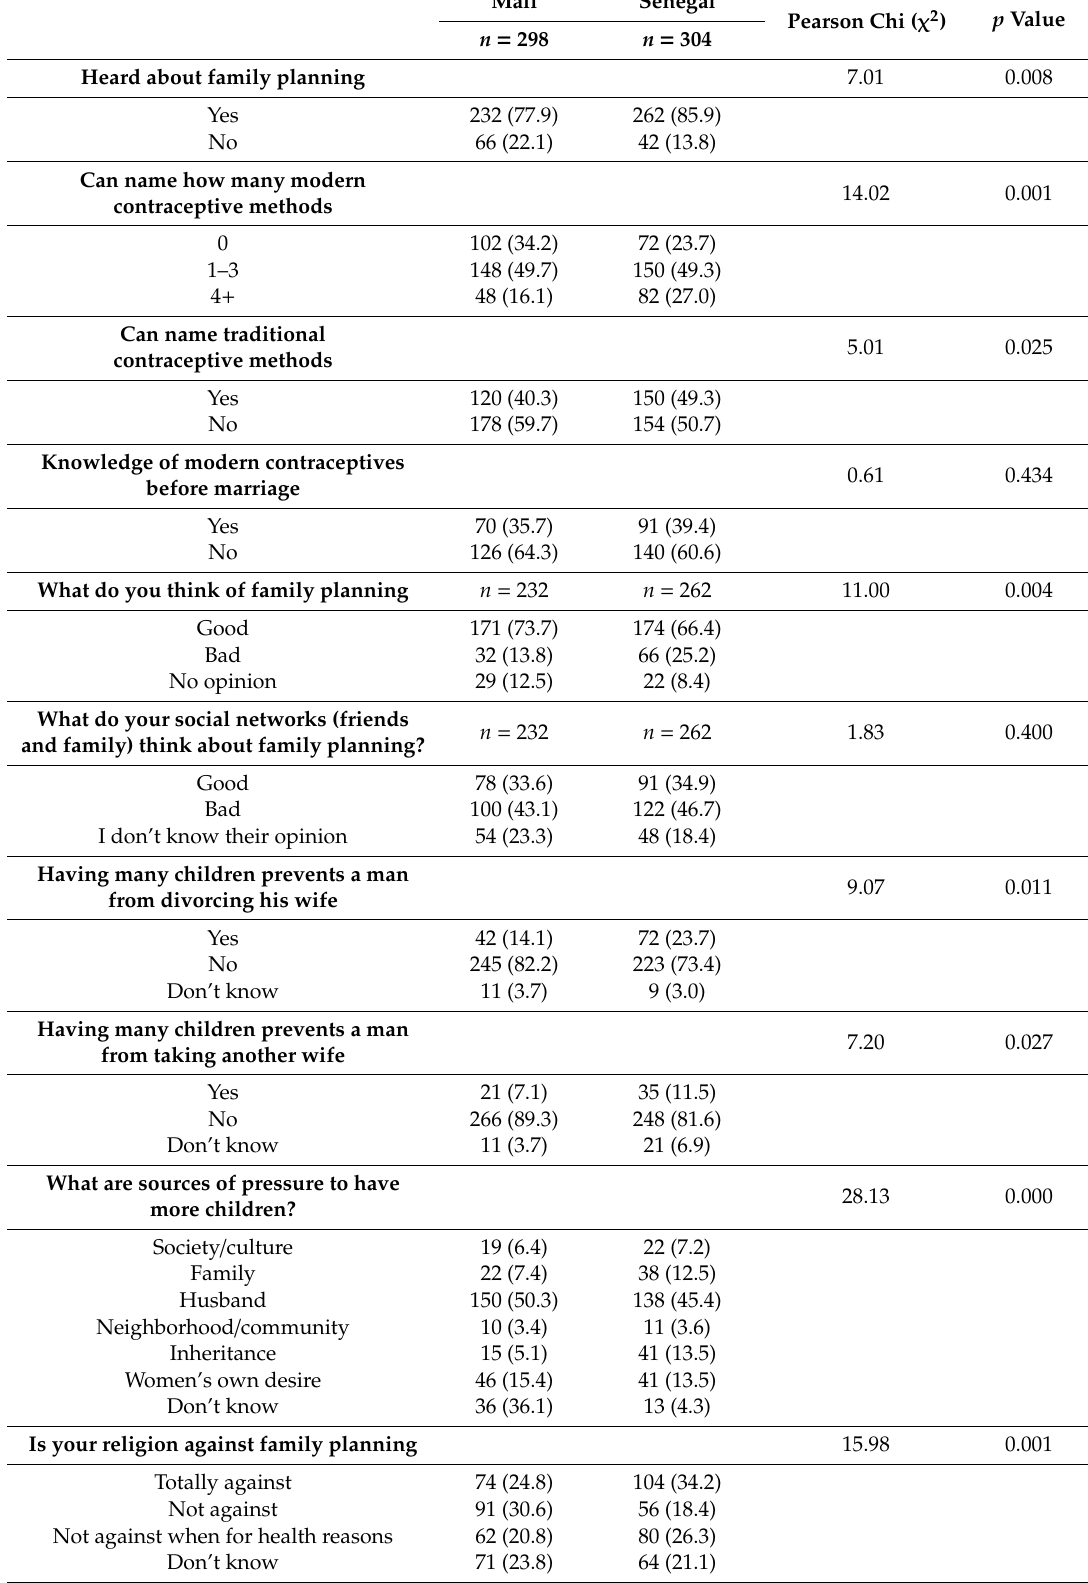
Table 2. Knowledge, attitudes, and beliefs about family